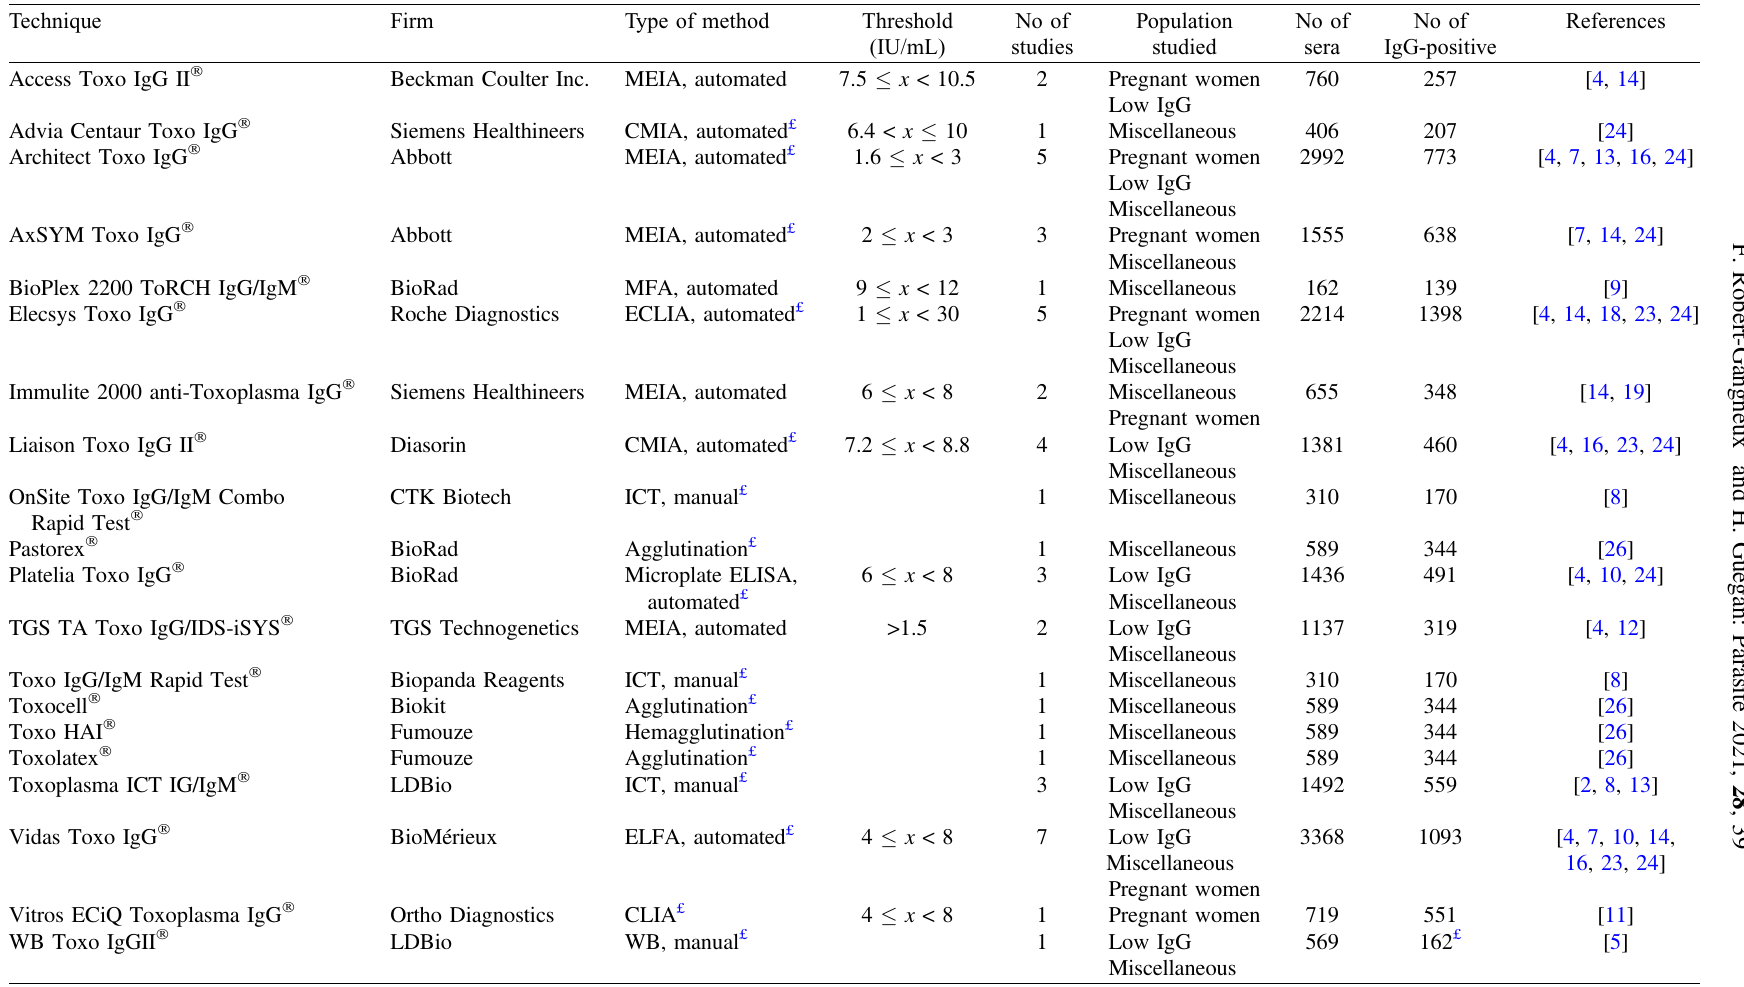
Table 1. Toxoplasma IgG commercial methods included: type of assay, number of evaluation studies, and population studied.